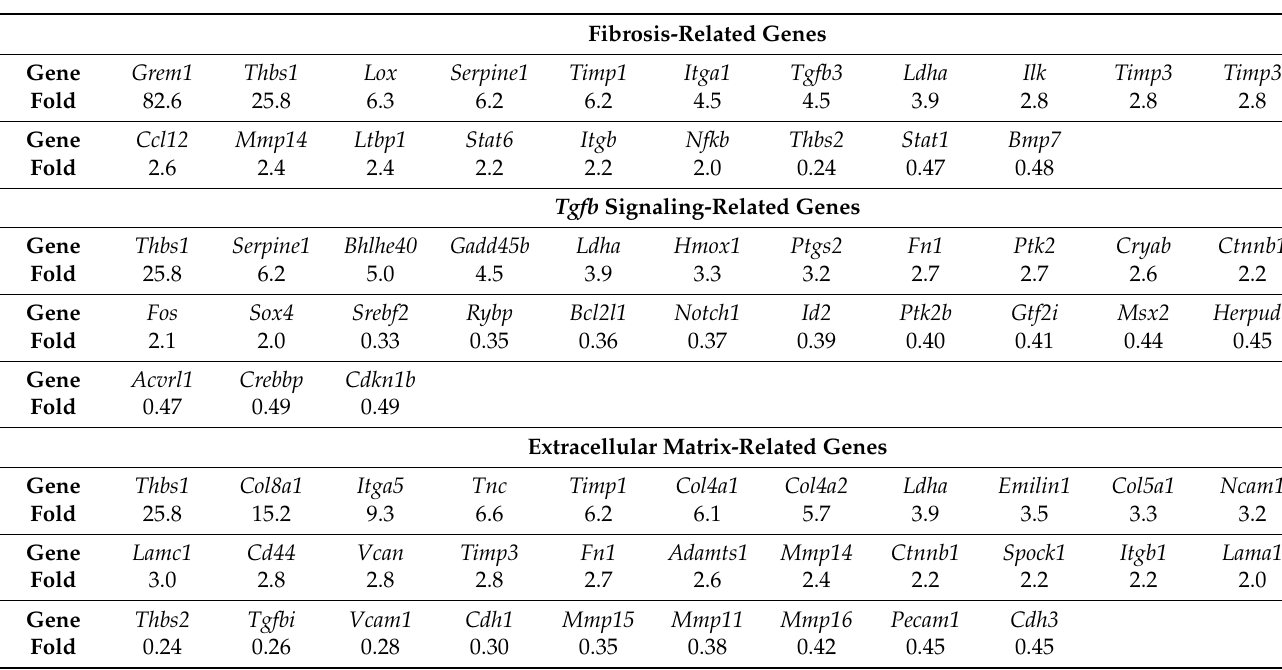
Table 1. DEGs related to fibrosis, Tgfb signaling, and extracellular matrix in the PBOO group. Fibrosis-Related